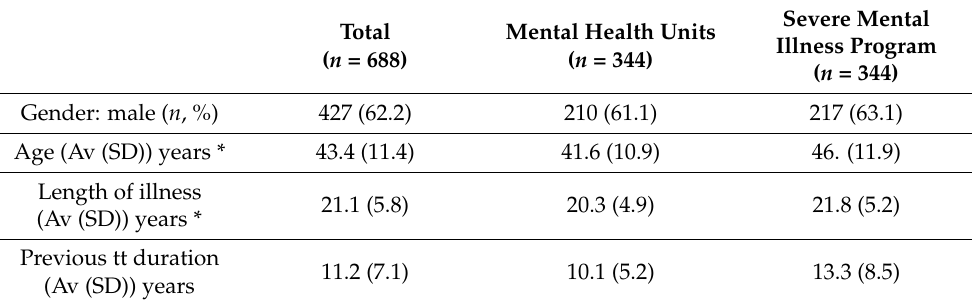
Table 1. Patients’ Sociodemographic and Clinical